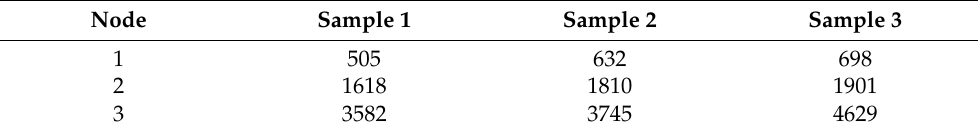
Table 3. Natural frequencies (Hz) after shock wave